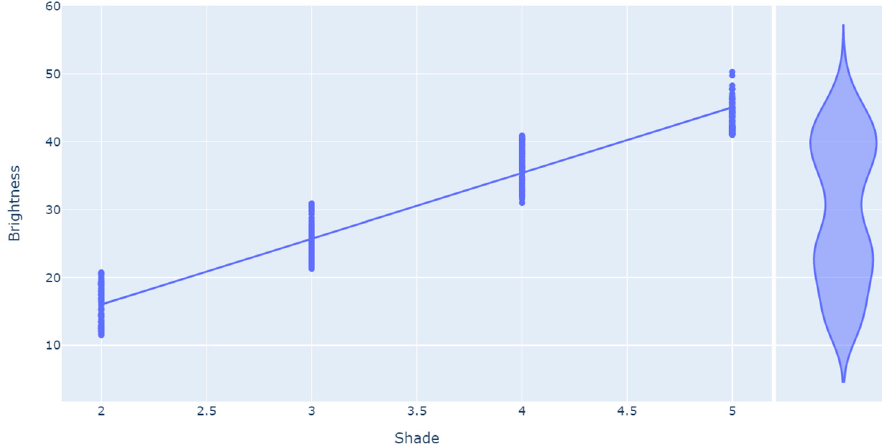
Figure 14. Scatter plot for shade and brightness.